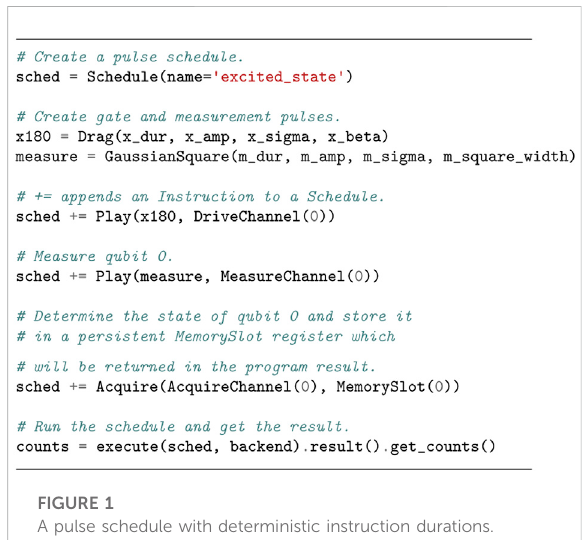
FIGURE 1 A pulse schedule with deterministic instruction